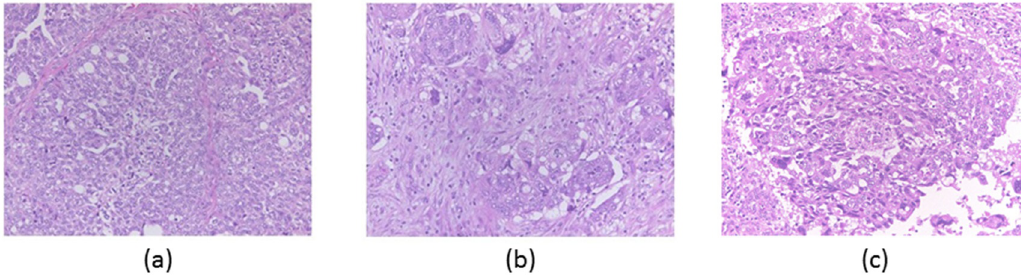
Figure 1. High-grade serous carcinoma with cells with glandular, papillary, and solid arrangement. Desmoplastic reaction gradually increasing from region ( a ) (left panel) → ( b ) (middle panel) → ( c ) (right panel) (×200).